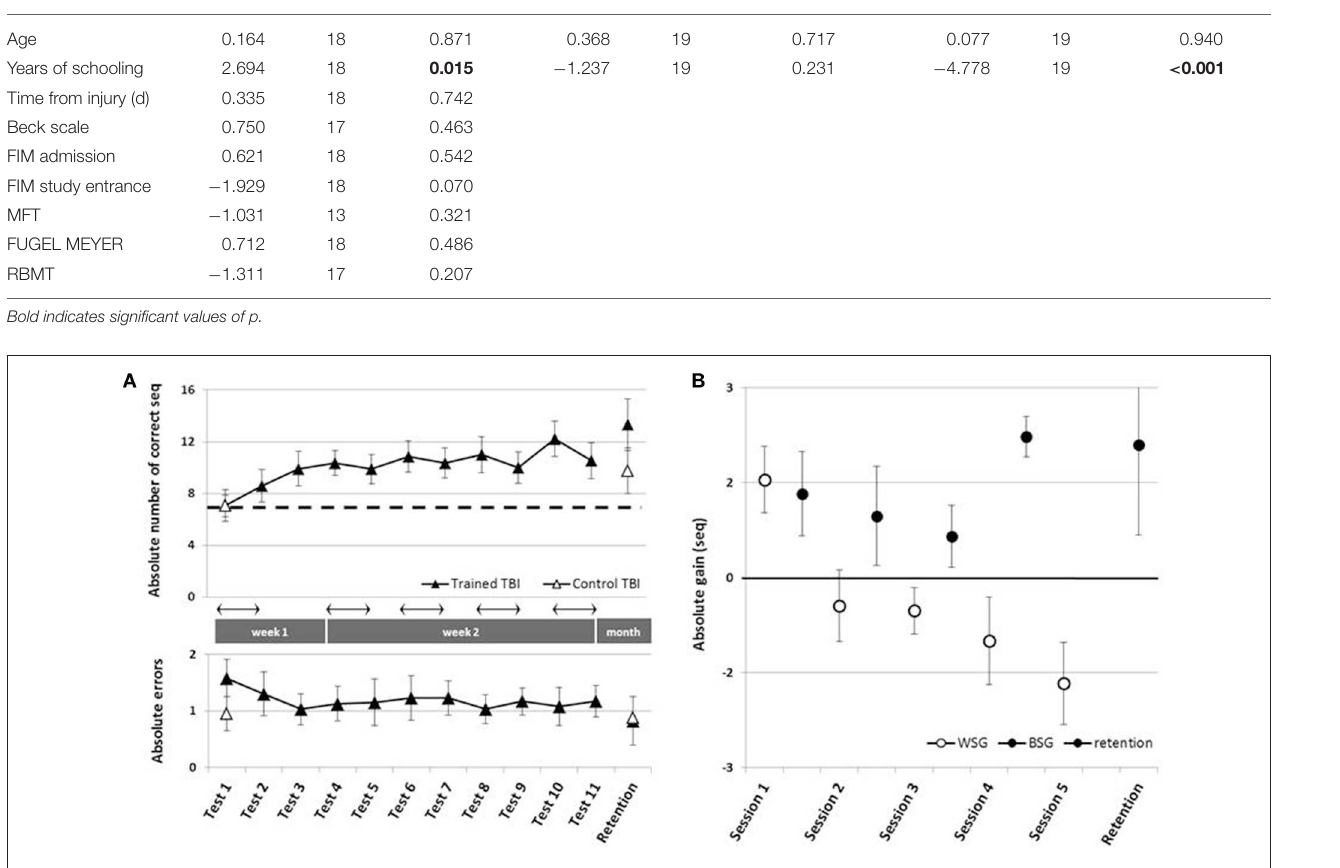
FIGURE 2 | Time-course of improvement across multi-session training. Open triangles–Control TBI group, filled triangles–Trained TBI group. (A) Speed and accuracy of performance across the training and the retention periods. Upper panel–speed; group average of the absolute number of correct sequences at each of the 11 performance tests and the retention test. Arrow–Session. Lower panel–accuracy; group average of the number of incorrect sequences performed at each test. (B) Absolute within-session and between-sessions gains in performance speed: the within-session gains (WSG)-black circles, were defined as the difference